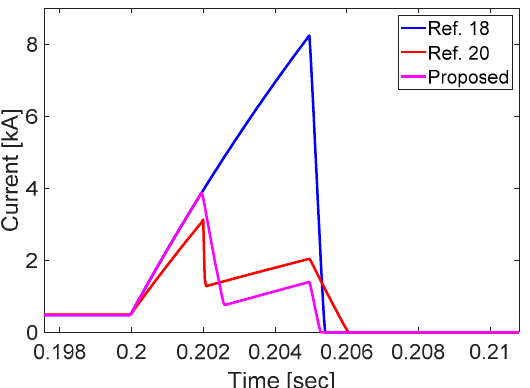
Figure 16. The response of DC current flowing through the system under the influence of di ff erent solutions.